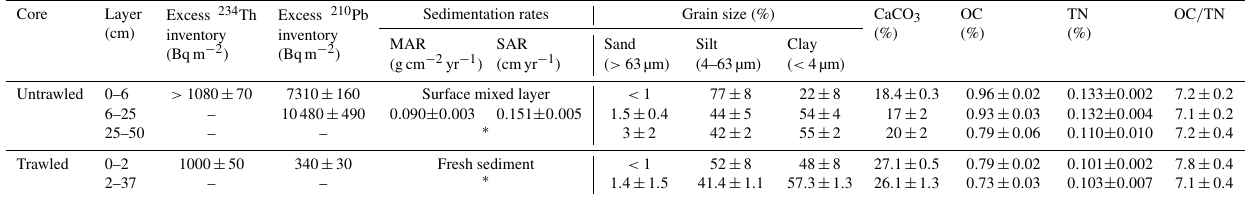
Table 1. Summary of the main parameters of the trawled and untrawled cores. Data for grain size, CaCO 3 , OC, TN, and OC / TN correspond to average values ± 1 standard deviation of that layer. MAR: mass accumulation rate; SAR: sediment accumulation